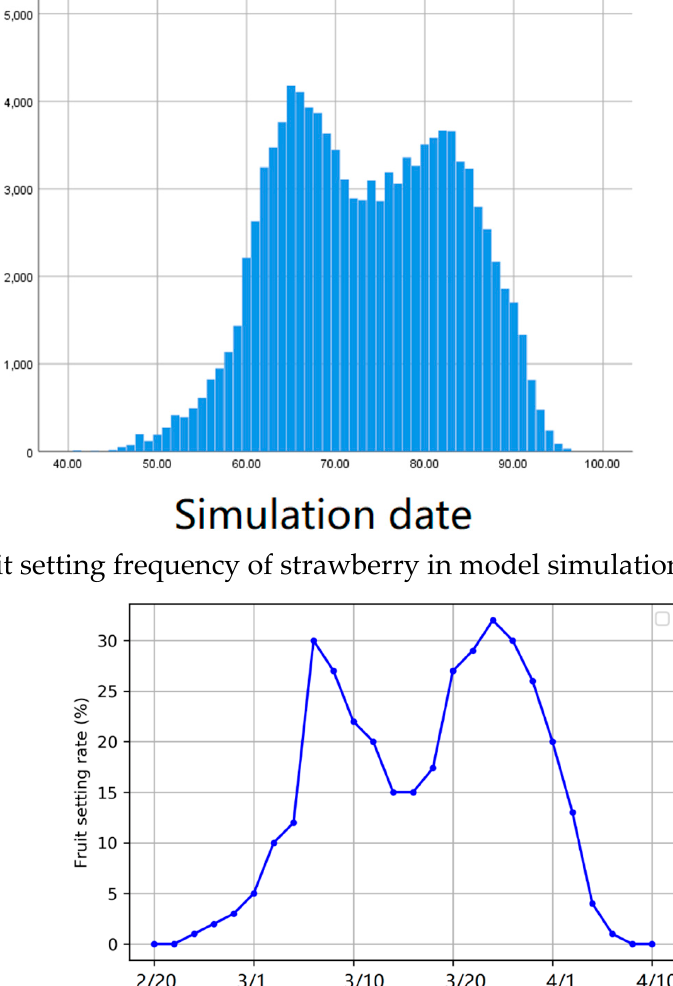
Figure 3. The blue line represents the fitted equation between the achene number in a berry and fruit weight in this simulation. The red dots represent the real strawberry berry information that we collected. More model validation are in the Supplementary Materials section. These experiment results suggested our model was firmly validated, which was considered to be critical to make precise assessments and suggestions for strawberry bee-pollination efficiency in a greenhouse. 3. Simulation Experiments For the first time, we closely analyzed the responses of fruit quality to different bee densities based on the firmly validated simulation model. 3.1. Experiment I: Bee Density and Fruit Quality Bee density in a greenhouse showed a strong positive correlation with fruit quality [15]. However, there is no universal conclusion about the relationship between the num- ber of strawberries and the number of bees in greenhouse planting. For example, McGregor recommended 12–25 colonies of honeybees per hectare of strawberries for op- timum fruit production [16], while Williams recommended 2.5 and Scott-Dupree 1.2 col- onies of honeybees per hectare [5]. Therefore, we conducted experiments to study the impact of bee density on straw- berry quality in a greenhouse. A series of simulation experiments with different bee-den- sity values (bee number from 2000 to 12,000) was conducted with the same other factors. Based on the results, the influence of bee density can be estimated quantitatively, and the